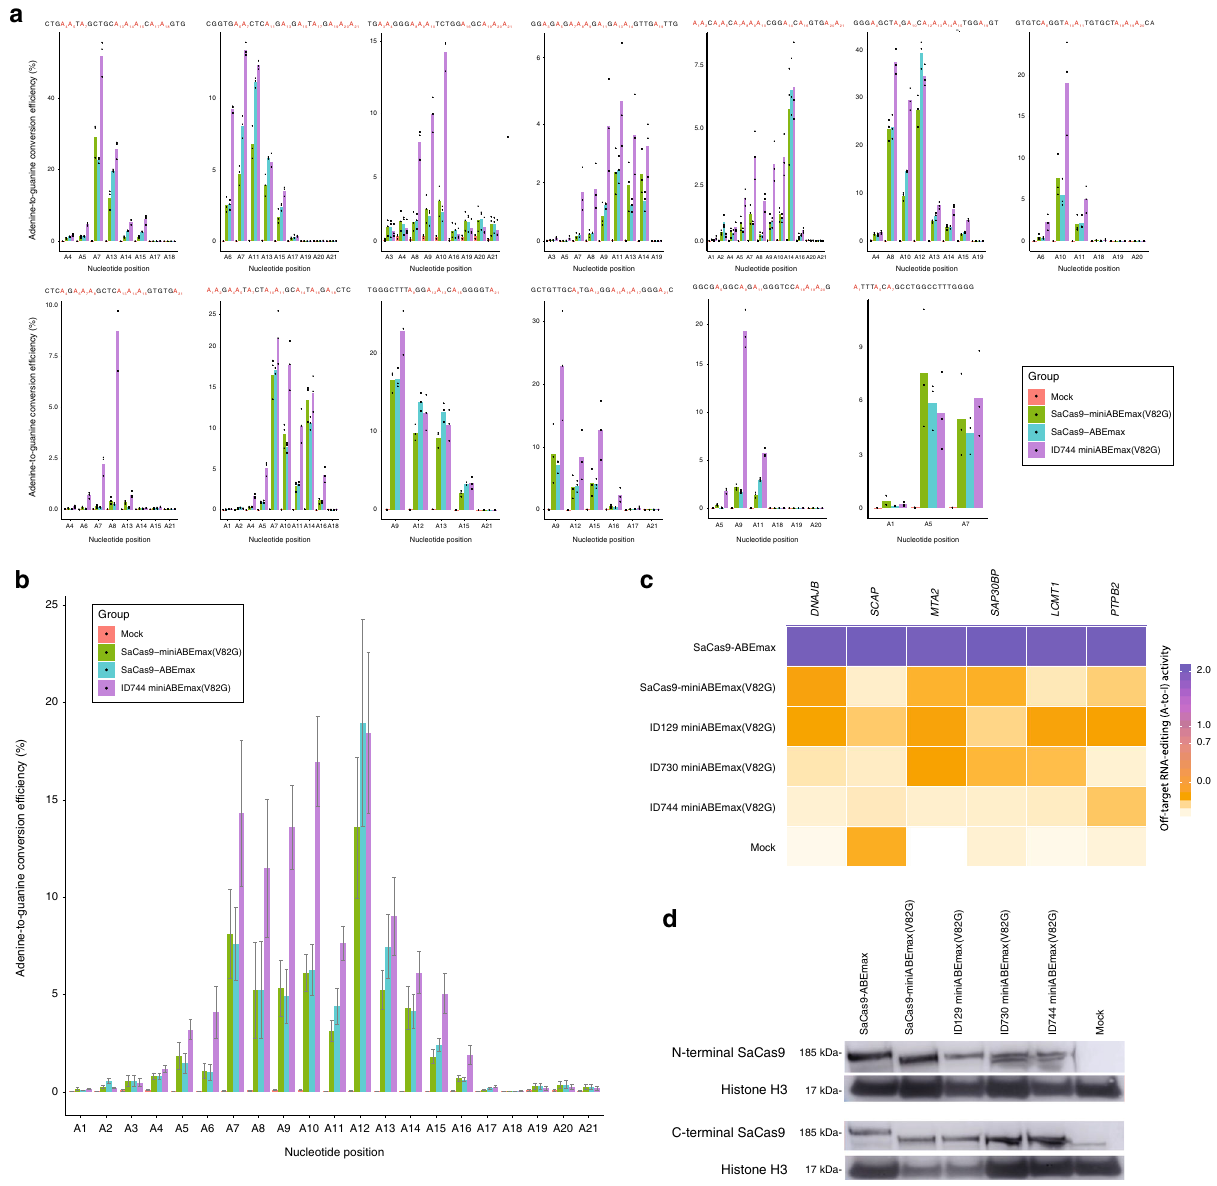
Fig. 3 Pro fi ling intradomain SaCas9 constructs in HEK293A-YFP cells. a On-target activity window in HEK293A-YFP cells. Editing ef fi ciency was determined at various adenine positions in a 21-nucleotide activity window using sgRNAs targeting 16 different loci ( n = 3 independent technical replicates performed on separate days). b Merged data of the average base editing showing A-to-G modi fi cations from ( a ) with microABE I744, SaABEmax, and Sa- miniABEmax (V82G), with each corresponding sgRNA. Data are presented as mean + / − SEM derived from a composite of independent sgRNA replicates and their respective technical replicates ( n = 3 for each sgRNA). c Off-target pro fi le of nSaCas9 constructs. Promiscuous RNA transcripts were assayed for the incidence of adenosine-to-inosine editing in the presence of nSaCas9-miniABEmax (V82G), nSaCas9-ABEmax, Intradomain-nSaCas9 I744 (microABE), Intradomain-nSaCas9 N730, and Intradomain-nSaCas9 G129. The most heavily edited adenine nucleotide of each transcript was considered for comparison. MiSeq data was considered across biological and technical replicates ( n = 9 in total). Adenine (A) to inosine (I) editing ef fi ciencies are shown as the mean value scaled from the lowest to highest value across all samples for all RNA off-target sites. d Western blot demonstrating immuno- binding of antibodies targeting the N- and C-terminal of SaCas9 constructs for each base editor tested ( n = 3 western blots performed on independent days). Source data are available in the Source data fi